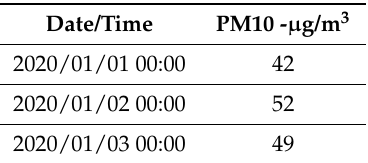
Table 1. The detected PM10 values for the city of Bergamo (Via Meucci Station), available on the ARPALombarida web site. The measures start from 2020/01/01, up to the date of writing. The − 999 value means a missing value.